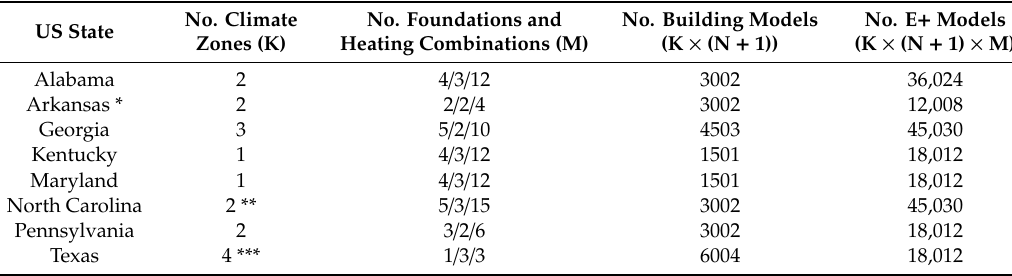
Table 3. Number of Building Model and Simulation